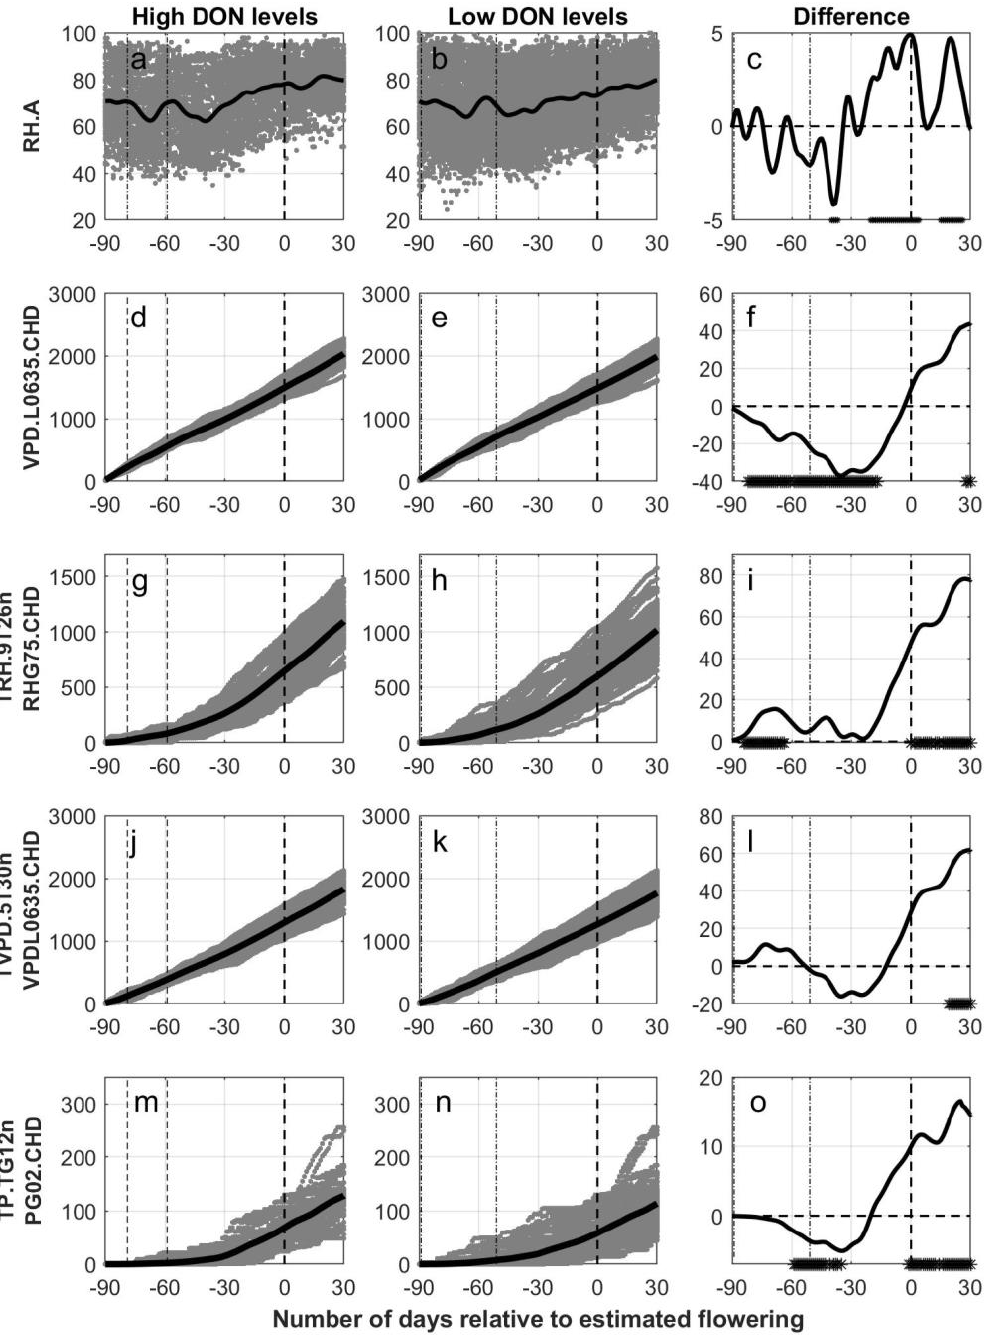
Figure 3. Calculated output data (gray) for five weather variables versus the number of days relative to estimated flowering in oats, grouped according to levels of deoxynivalenol (High DON levels, first column of panels (subfigures ( a , d , g , j , m )): DON ≥ 500 µg pr kg harvested oat. Low DON levels, second column of panels (subfigures ( b , e , h , k , n )): DON < 500 µg per kg harvested oat). Black lines indicate the functional mean values of the smooth functions derived from individual sets of weather data. In the third column of panels (subfigures ( c , f , i , l , o )), the difference between the functional mean curves (high – low) are given as black lines with a dot at the bottom of each panel indicating signifi- cant differences between the mean values (5% level). Weather data is presented from 90 days prior to 30 days posterior to flowering (dashed line at 0) estimated with the use of the phenological model (OPM1.1). In all panels, the two dash-dotted lines indicate the start and end of the period of sowing for the different fields. RH.A = daily average relative humidity, VPD.L0635.CHD = cumulative num- ber of hours with vapour pressure deficit lower than 0.635 kPa, TRH.9T26nRHG75.CHD = cumula- tive number of hours with temperature between 9 and 26 °C combined with a relative humidity greater than 75%, TVPD.5T30nVPDL0635.CHD = cumulative number of hours with temperature between 5 and 30 °C combined with vapour pressure deficit lower than 0.635 kPa and